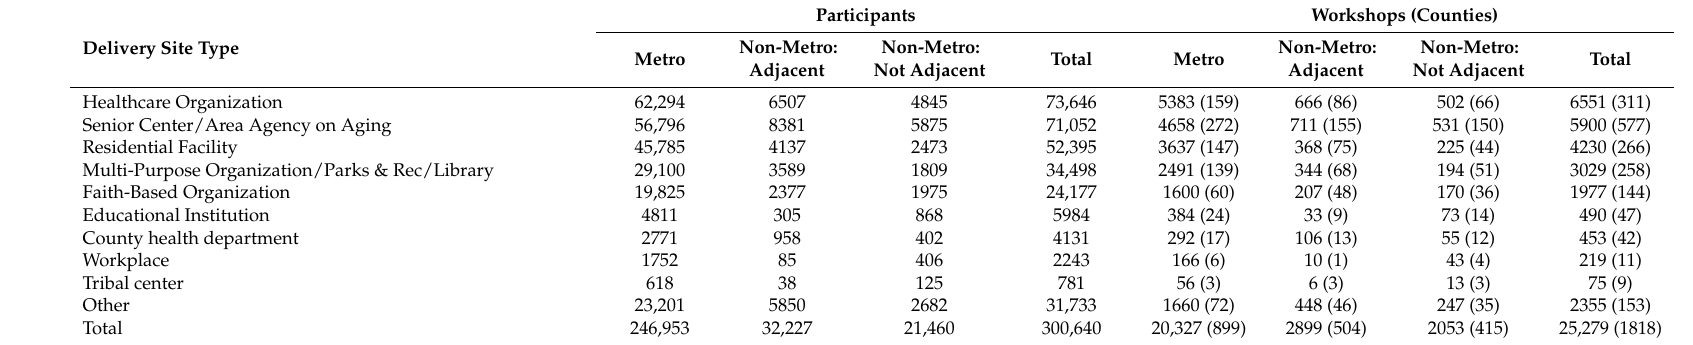
Table 2. Delivery site types by